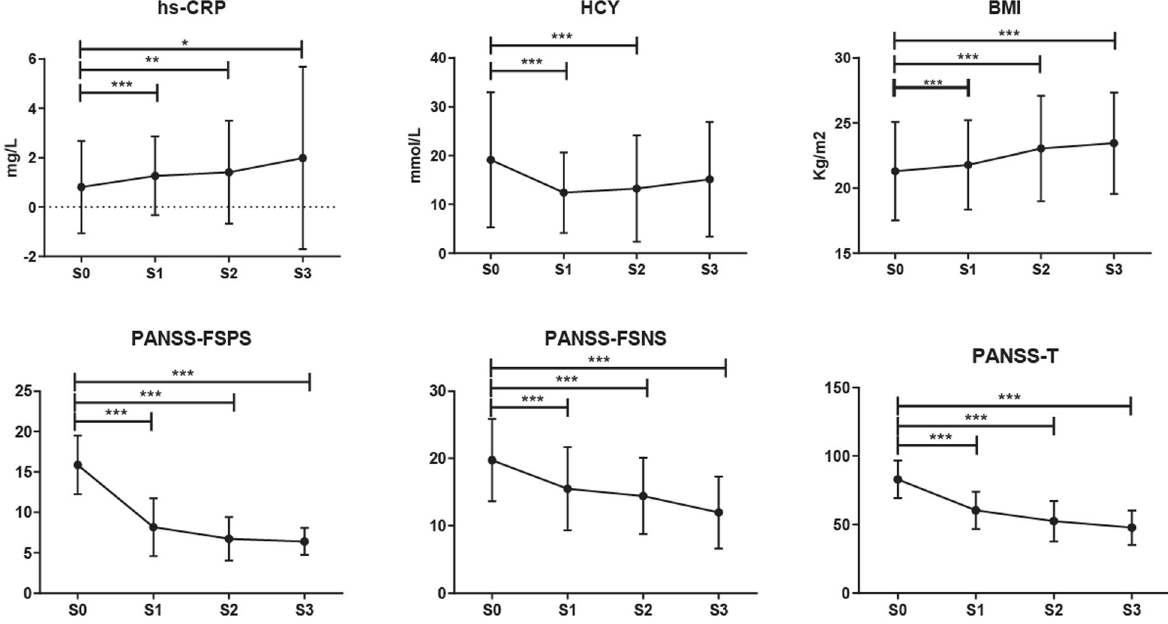
Fig. 1 The dynamic changes of in fl ammatory biomarkers and clinical improvements. The dynamic changes of BMI, in fl ammatory biomarkers hs-CRP and HCY in SCH patients. PANSS scores show a signi fi cant decrease after risperidone treatment. * p < 0.05, ** p < 0.01, *** p < 0. 001. The means and standard deviation are indicated in the bar chart. FDR were used to correct the multiple testing.